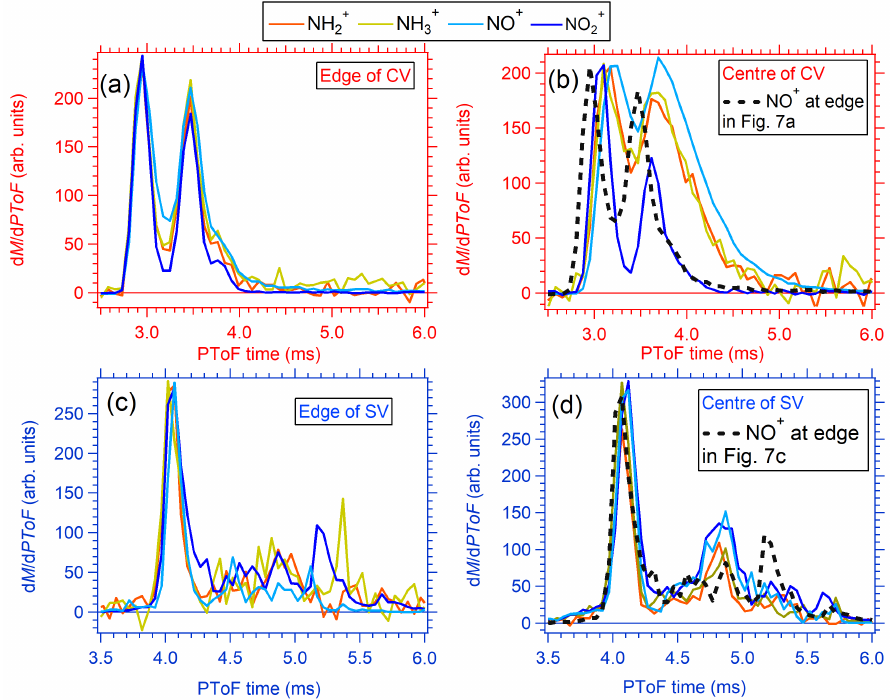
Figure 7. Size-resolved detection of NH 4 NO 3 (DMA selected 300nm particles, including some larger doubly charged particles ) major ions using the PToF acquisition mode at (a) the CV edge (position = 7.6mm in Fig. 5), (b) the CV centre (position = 7.1mm in Fig. 5), (c) SV edge (position = 8.4mm in Fig. 6) and SV centre (position = 7.9mm in Fig. 6). All the peaks were normalized to the NO + maximum. Note that the size distributions of the particles were identical within each panel, and that the differences observed between the different ions are due to vapourization and other effects. (see main text). The experiments for the SV and CV were performed at different times, and the fraction of doubly charged particles was lower for the SV